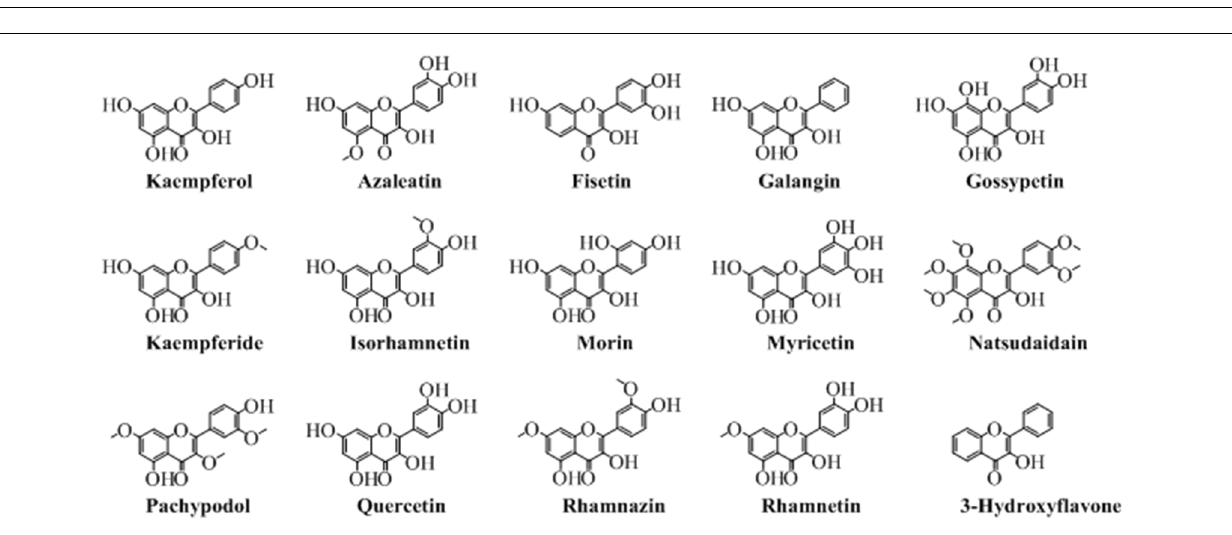
FIGURE 4 | The chemical structures of major flavones derived from natural and synthetic origin.